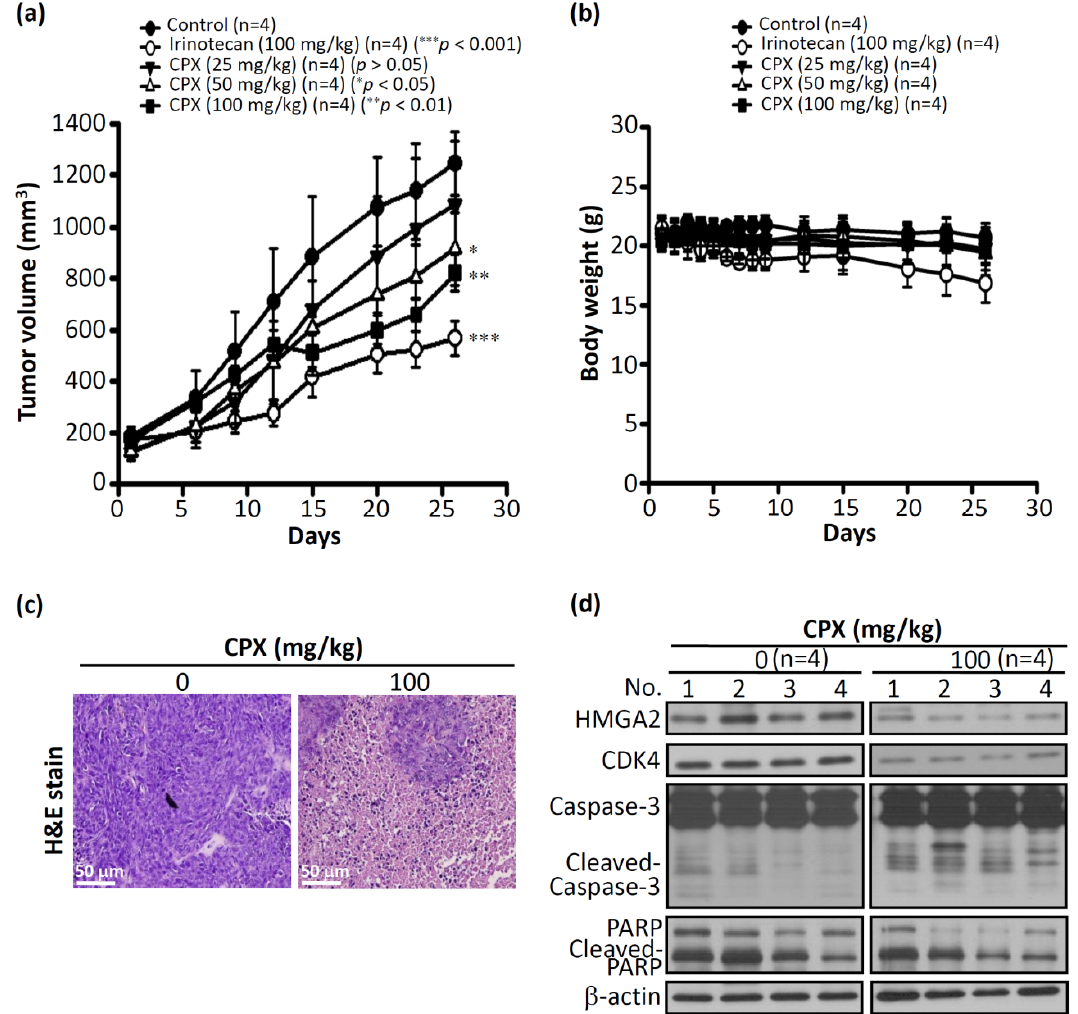
Figure 4. CPX inhibits tumor growth in human CRCHCT116 xenografts in mice. ( a ) Nude mice-derived HCT116 xenograft tumors under indicated treatment: oral gavages with CPX (25, 50, and 100 mg / kg), a vehicle control group, and a positive control group (irinotecan 100 mg / kg), as described in Material and Methods. The tumor volume measurement was performed at indicated times (days). Results are presented as mean ± SD ( n = 4). ( b ) No signs of acute toxicity were observed as assessed by weight loss of less than 10%. ( c ) Tumors were excised from the animals; this was followed by hematoxylin and eosin (H&E) staining. ( d ) Western blot analysis of intratumoral biomarkers of CPX activity in four representative HCT116 tumors from two groups of mice. p < 0.05 was considered to be statistically significant. * p < 0.05, ** p < 0.01, *** p < 0.001.